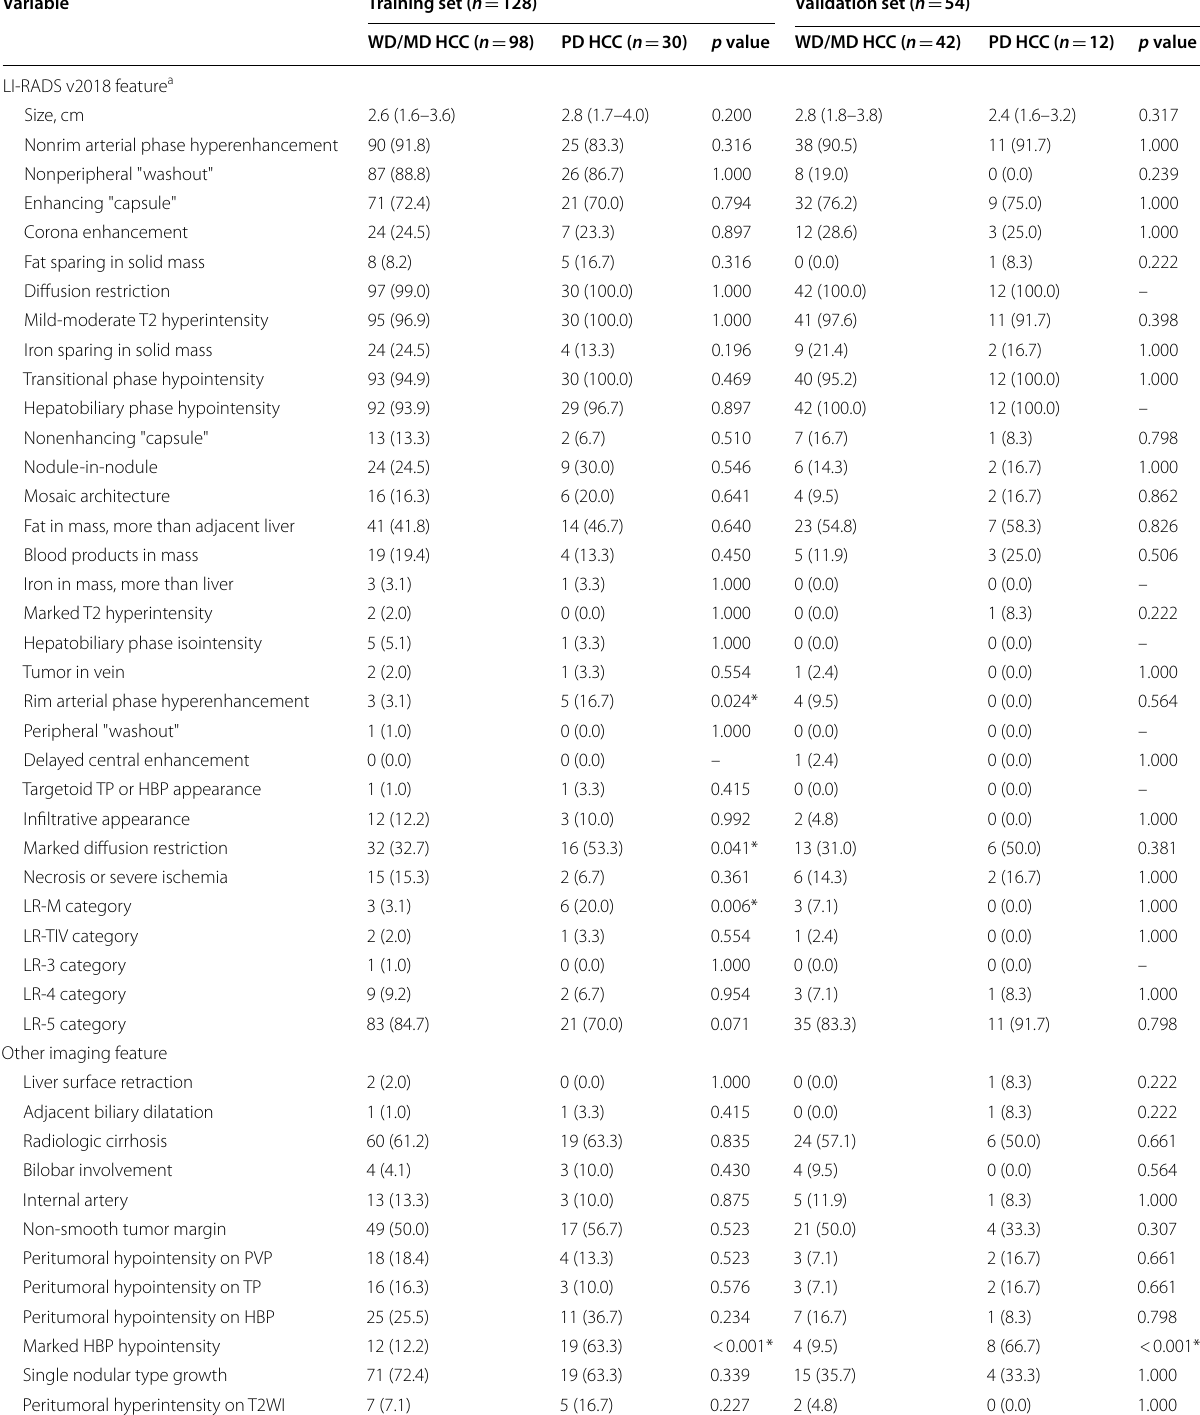
Table 2 Frequencies of EOB-MRI